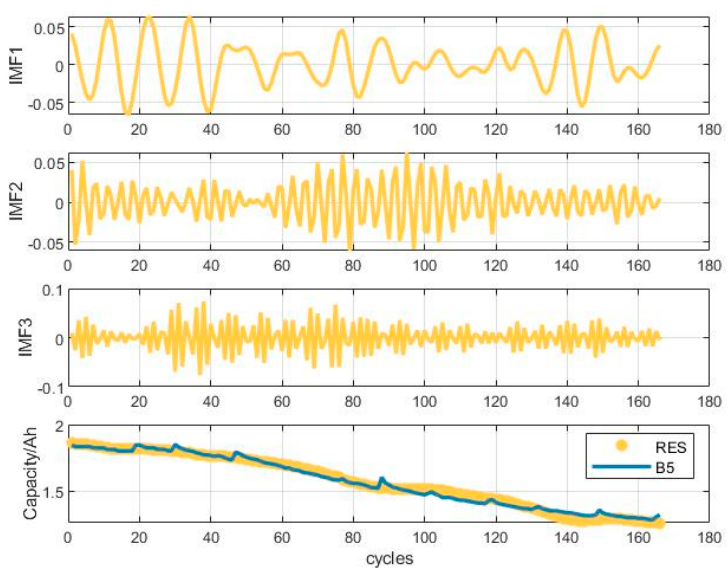
Figure 5. VMD result of B5.